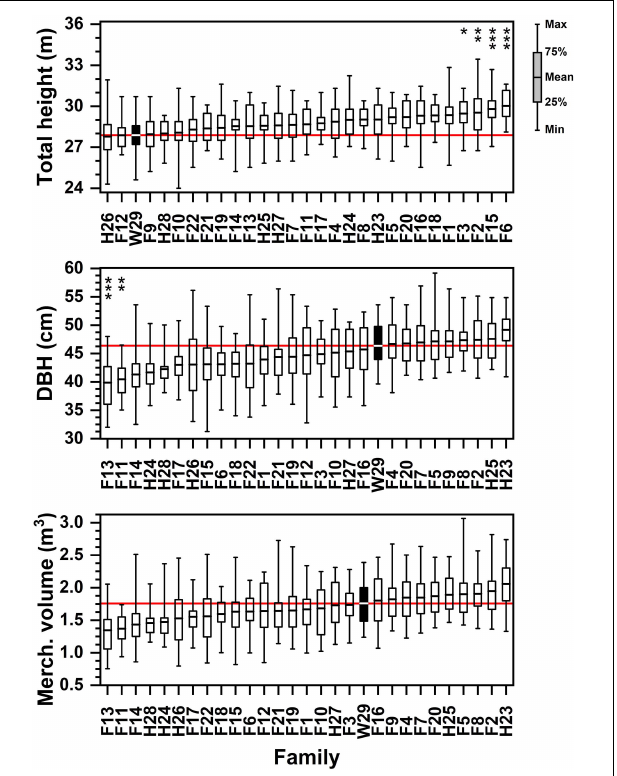
FIGURE 2 | Ordered rankings of progeny test performance measures by attribute (total tree height, DBH, merchantable volume) means from data collected in February–March 1994. The open-pollinated Crossett Experimental Forest family (W29) highlighted by black bar, with solid red line showing W29 mean value. Bars represented range of observed values from minimum to maximum; boxes represent 25th and 75th percentiles of sampled data. Asterisk (stacked vertically) above data reflect families significantly lower or higher than W29 at the following significance levels (* = 0.05 ≤ p < 0.01; ** = 0.01 ≤ p < 0.001; *** = p ≤ 0.001).